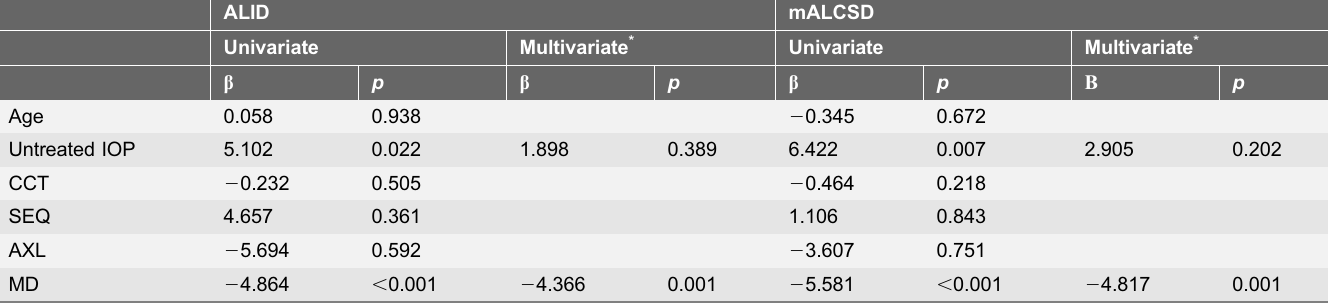
Table 7. Factors affecting anterior laminar cribrosa insertion in primary open angle glaucoma.